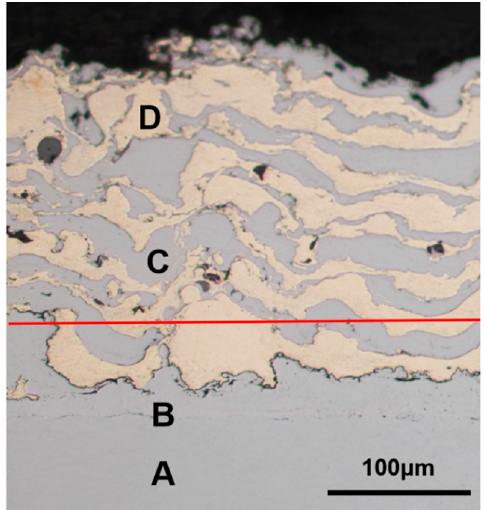
Figure 10. Cross-sectional view of composite coating: A—45 steel substrate; B—Mo layer; C—aluminum bronze layer; and D—high-carbon steel layer.